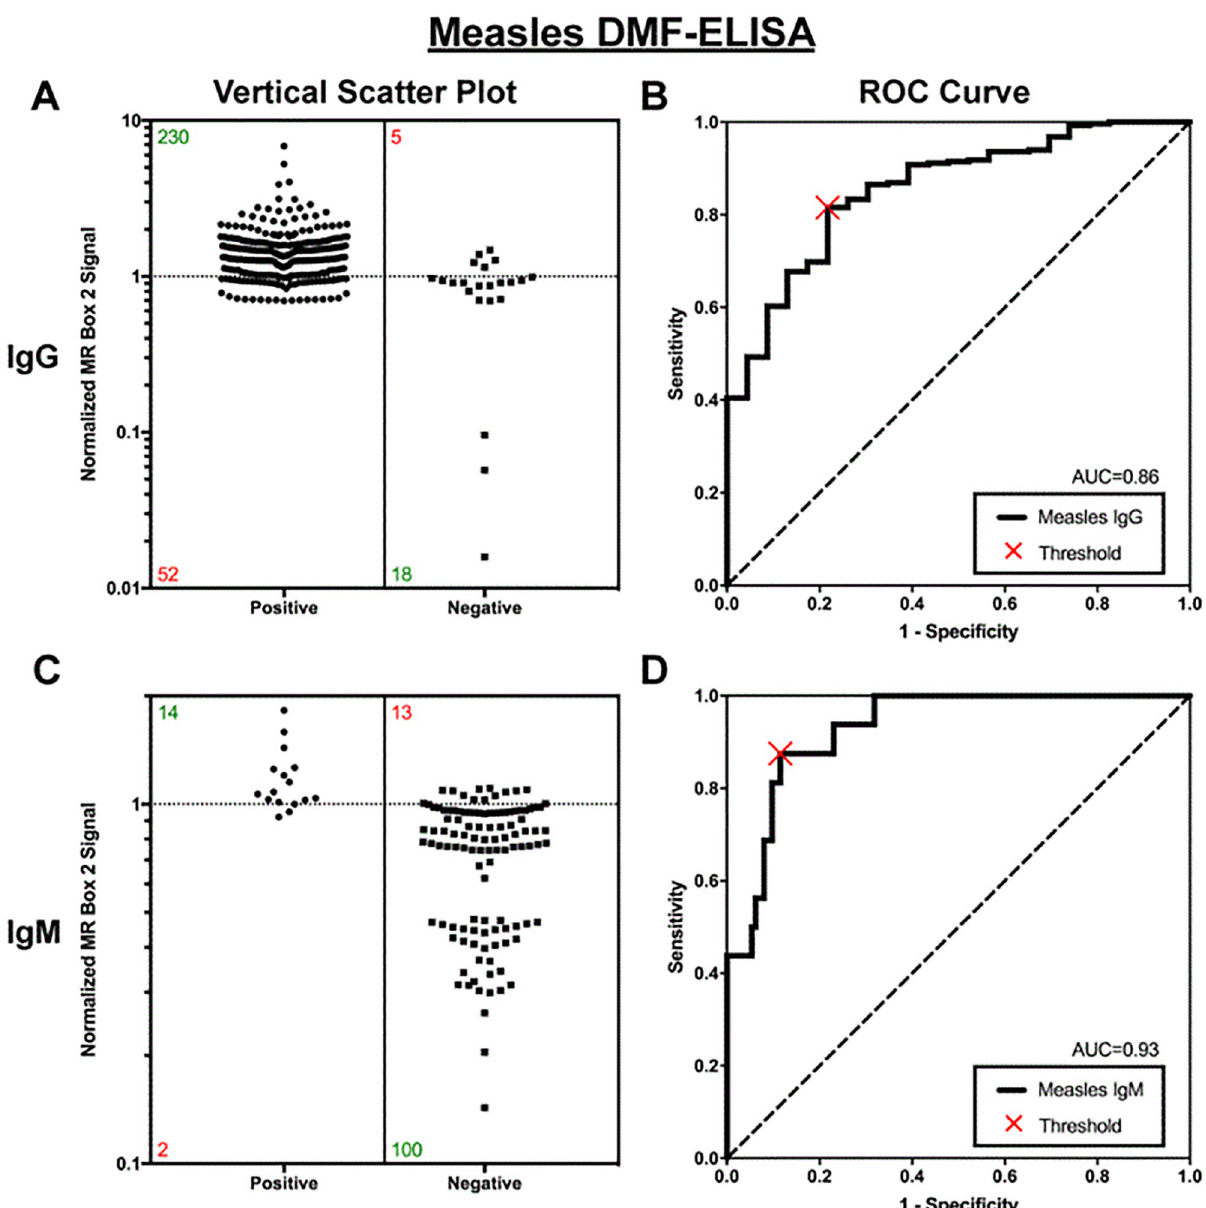
Fig 2. Performance of DMF-ELISA for assessing 305 specimens for measles IgG (A and B) and 129 specimens for measles IgM (C and D) compared with a reference ELISA. (A and C) Vertical scatterplot (left) of MR Box 2 signals for specimens determined to be positive or negative for anti-measles IgG (top, n = 305) and IgM (bottom, n = 129) by reference tests. Green and red numbers in the scatterplot represent the number of specimens correctly and incorrectly categorized by the MR Box 2, respectively. (B and D) Receiver Operating Characteristic (ROC) curves with an optimized threshold